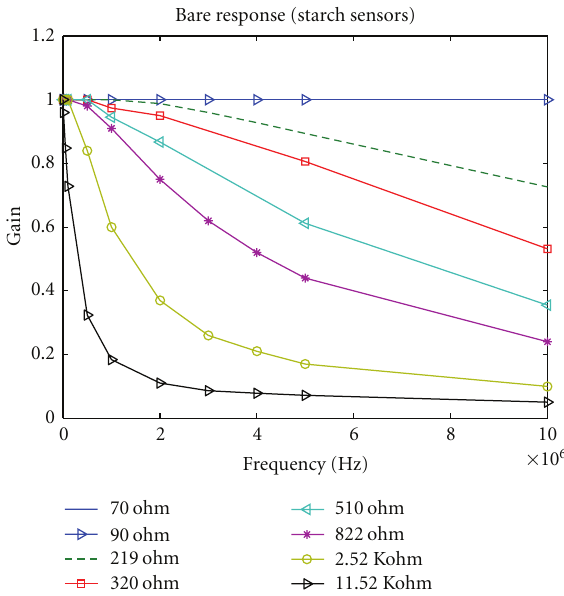
Figure 2: Gain-frequency response for sensors having resistance from 70 Ω to 11.52 K Ω